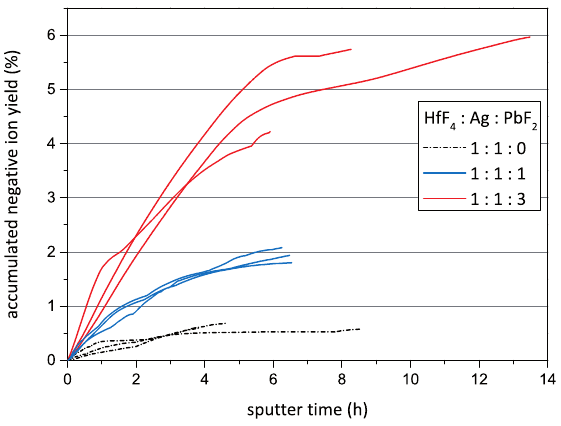
as a function of 5